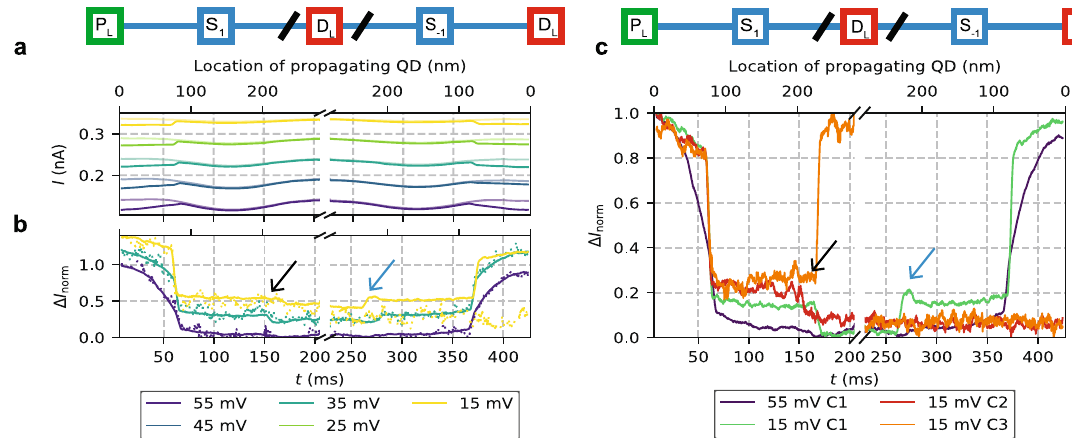
Fig. 3 Electron transfer characteristic. The pulse sequences is indicated above the panels, where the black bars mark the cut in time axis for panels below. a Comparison of the average shuttling signal with (dark) and without (light, reference signal) an electron loaded for different amplitude A S values measured by the left SET compensated for cross-capacitive coupling. Shuttling signals with B S = 730 mV, Δ B S = 100 mV and f = 5 Hz, are used. For better orientation, the upper x -axis indicates the minimum location of the propagating QD assuming constant shuttling velocity. The curves are offset by 0.05 nA for clarity. b Normalized difference of average SET currents (solid) and single traces (dotted) with one and without an electron loaded (from a ) for different amplitude A S . The curves are offset by 0.1 for clarity. c For A S = 15 mV, 100 traces are bundled into three different categories: the intended transfer (C1) and two different failure modes, with Δ I norm = 0 during S − 1 , if the electron is not detected by any D L (C2) or the electron is detected during the fi rst D L segment (C3). Each bundle is averaged and normalized separately. The black and blue arrows in b highlight abrupt changes in Δ I norm